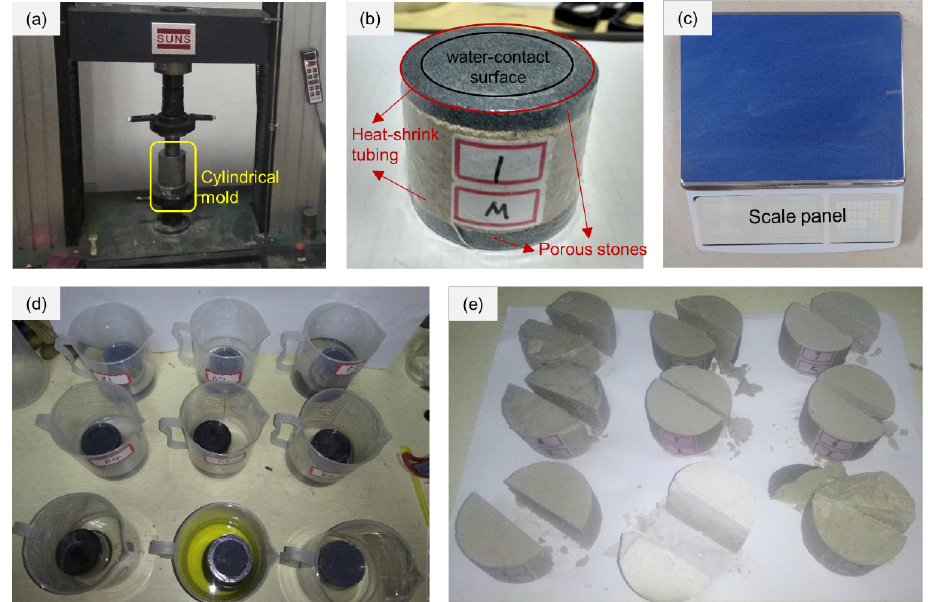
Figure 2. Test processes: ( a ) Cylindrical mold under hydraulic uniaxial compression; ( b ) Packaged sample to be tested; ( c ) High-precision electronic scale; ( d ) Water absorption process of samples; ( e ) Saturated sample at the end of the tests.